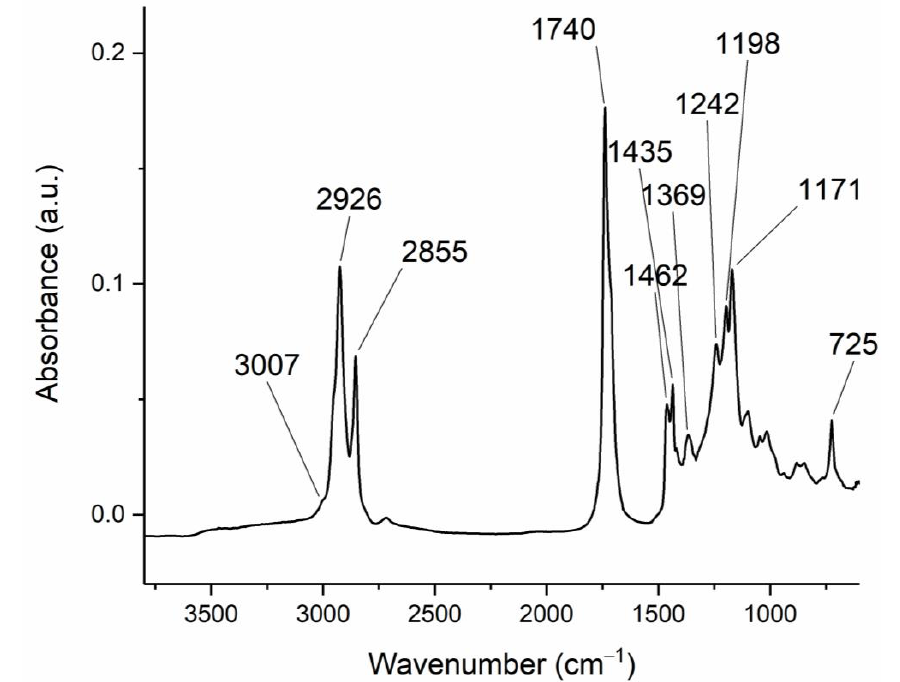
Figure 12. FT-IR spectrum for oxidized canola FAME product.